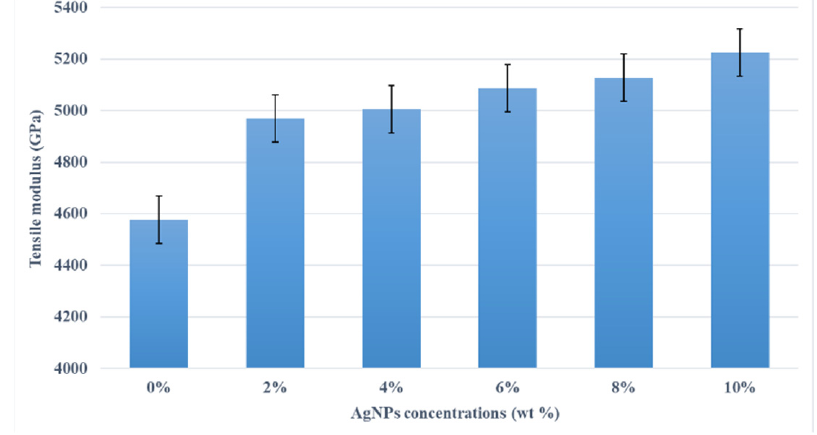
Figure 6. Effects of AgNP content on tensile modulus of kenaf/HDPE composites.